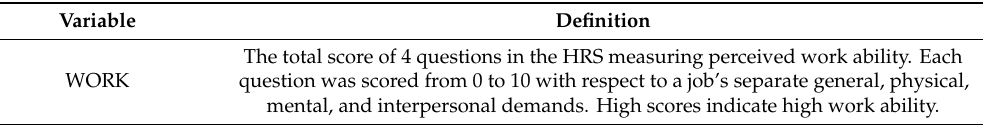
Table 1. Definitions of variables.